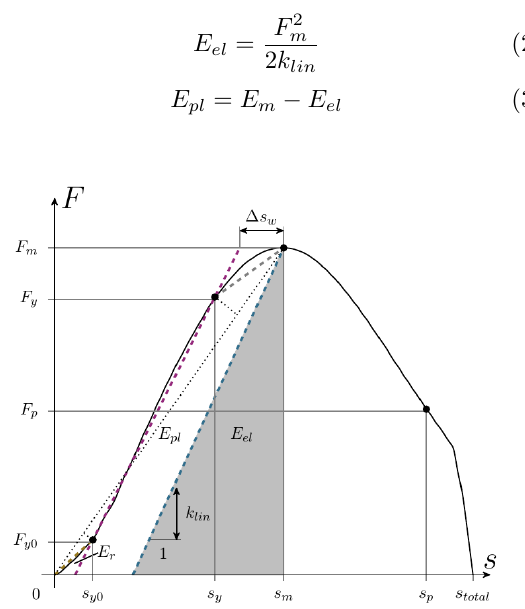
Figure 2. Evaluation of force-deflection